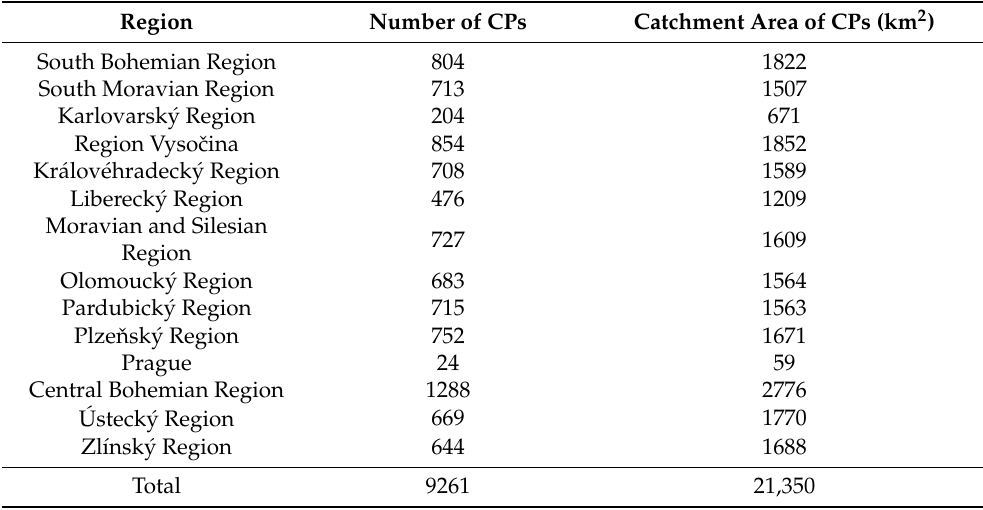
Table 1. Overview of territorial representation of generated CPs in the Czech Republic. Region Number of CPs Catchment Area of CPs (km 2